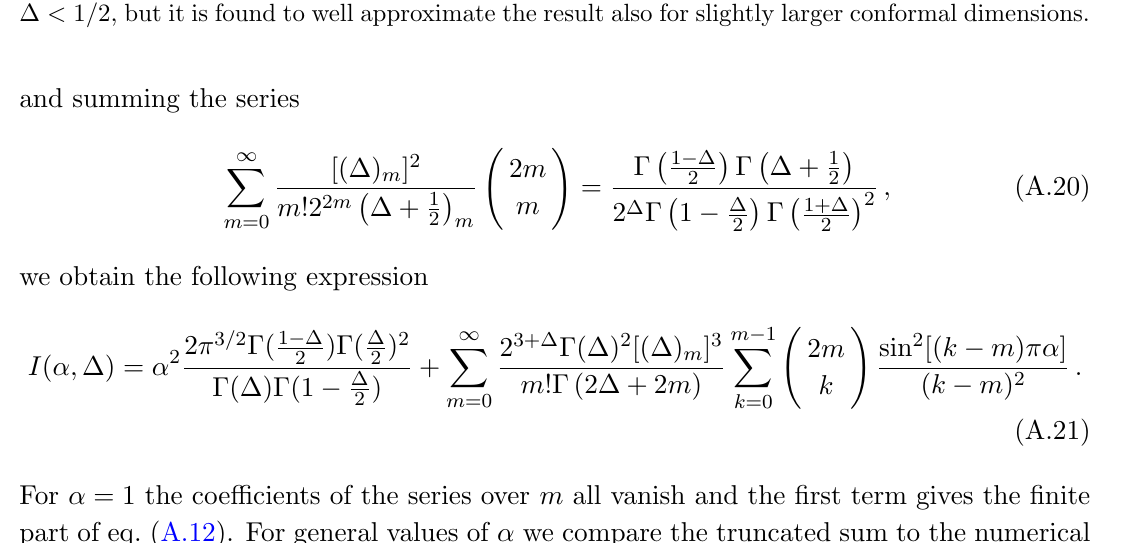
Figure 13 . Numerical integration of I ( (cid:11); (cid:1)) for (cid:11) = 0 : 4 and (cid:15) = 0 : 0001 compared to the series representation (A.21) truncated at m = 3000 (brown dots). In light orange (cid:11) 2 I (1 ; (cid:1)), which well approximates the full result for small (cid:1). The series representation we worked out strictly holds for (cid:1) < 1 = 2, but it is found to well approximate the result also for slightly larger conformal